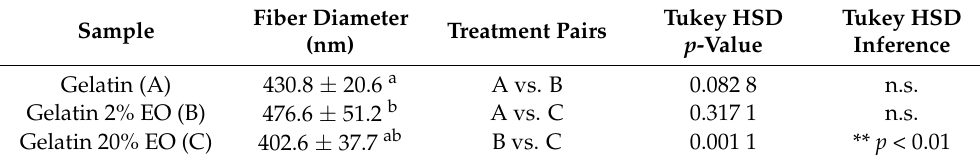
Table 9. Diameters of prepared fibers by electrospinning.